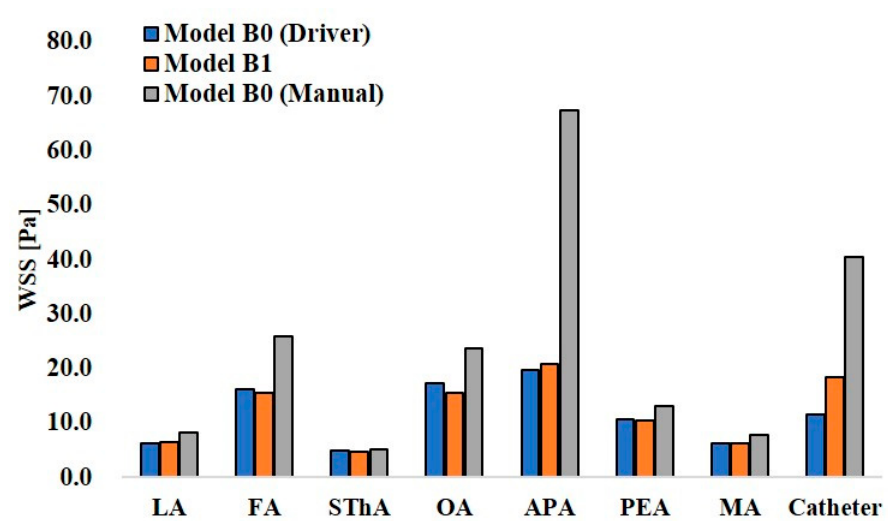
Figure 12. Wall share stress in models A0 and A1.